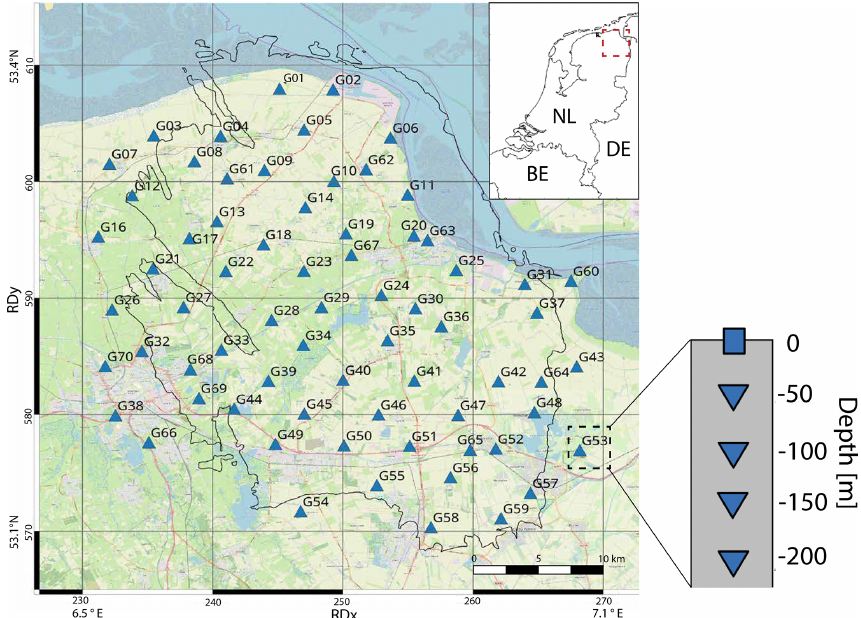
Figure 2. Map view of the Groningen area. The triangles represent the surface location of the stations of the G-network. Each station contains an accelerometer at the surface (square) and four geophones at 50m depth intervals (inverted triangles). Coordinates are shown within the Dutch National Triangulation Grid (Rijksdriehoekstelsel or RD) and lat/long coordinates in the corners for international refer- encing. Background map: © OpenStreetMap contributors, CC-BY-SA, https://www.openstreetmap.org/#map=6/51.330/10.453 (last access: October 2019). Table 1. List of teleseismic events used for this study. The epicentral distance and back azimuth are calculated for reference station G24. Event Magnitude Origin Origin Epicentral Back azimuth date time (UTC) distance (km) ( ◦ ) Mexico (Chiapas) 8.1 8 September 2017 04:49:21 9356 287.4 Alaska (Kodiak) 7.9 09:31:42 7663 345.9 Venezuela (Sucre) 7.3 21:31:44 7718 Peru 8.0 Southern California